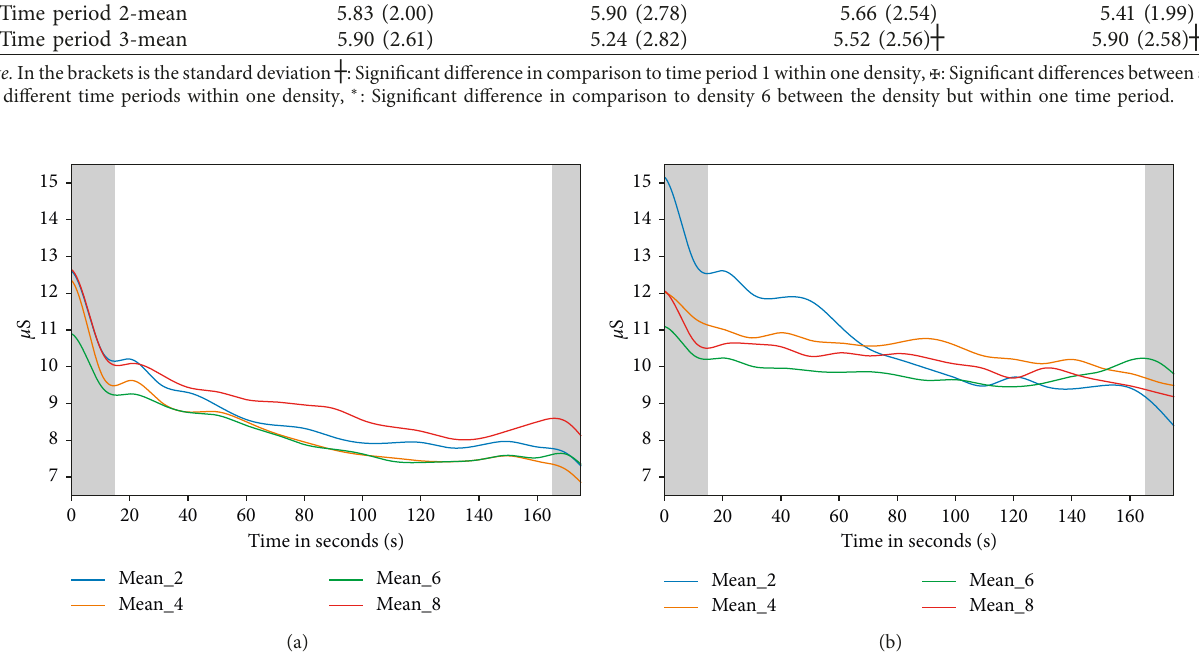
Figure 13: (a) Representation of the SCL averaged over all test subjects in the silent condition for all densities. (b) Representation of the SCL averaged over all test subjects in the speaking condition for all densities.